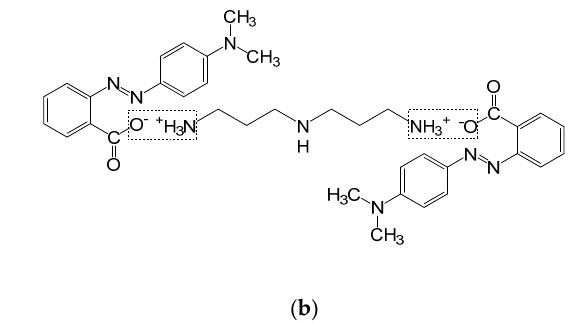
Figure 1. ( a ) The chemical structure of MR and BAA. ( b ) Ionic bonding process between MR and 71 BAA.